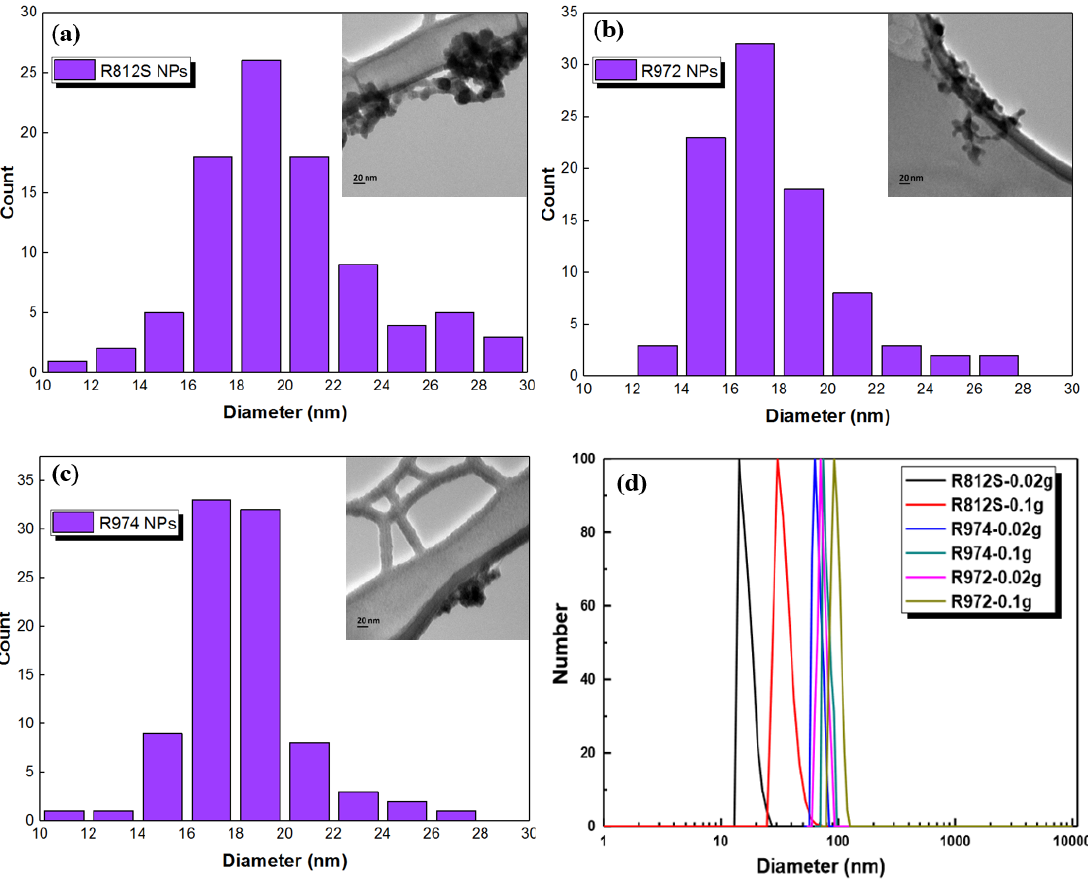
Figure 3. ( a – c ) Number of NPs per size and TEM images (inserted) of the three types of alkyl-silica NPs, the size distribution of each NP was determined based on 100 NPs of each type; ( d ) diameters of the NPs at different concentrations in the isopar-G solvent as measured by DLS.